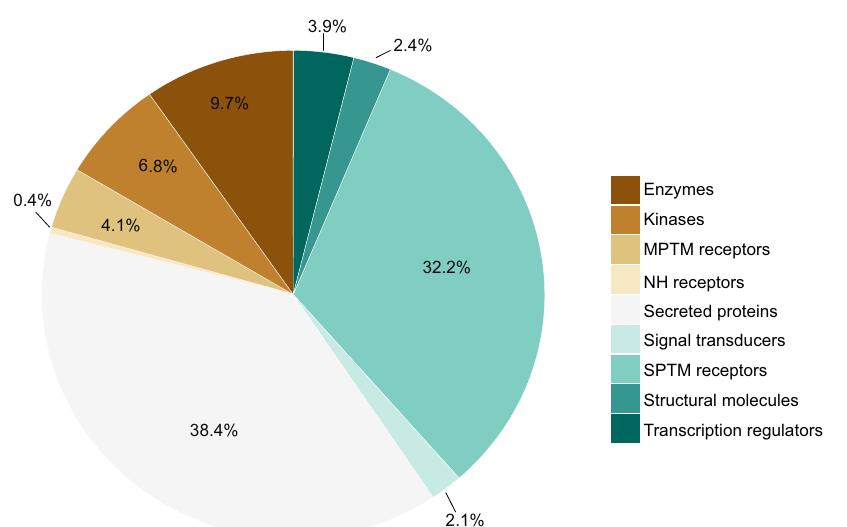
Fig. 1 Classi fi cation of the target protein population. The pie chart shows the relative distribution (percentage) of the different protein classes targeted by the present proteomics platform (4137 unique proteins), with secreted proteins (38.4%) and single-pass transmembrane (SPTM) receptors (32.2%) dominating the target protein population. Protein classes were manually curated based on information from the SecTrans, Gene Ontology (GO), and Swiss- Prot databases, and were composed of secreted proteins (e.g., cytokines, adipokines, hormones, chemokines, and growth factors), SPTM receptors (e.g., tyrosine and serine/threonine kinase receptors), multi-pass transmembrane (MPTM) receptors (e.g., GPCR, ion channels, transporters), enzymes (intracellular), kinases, nuclear hormone receptors (NH receptors), structural molecules, transcriptional regulators and signal